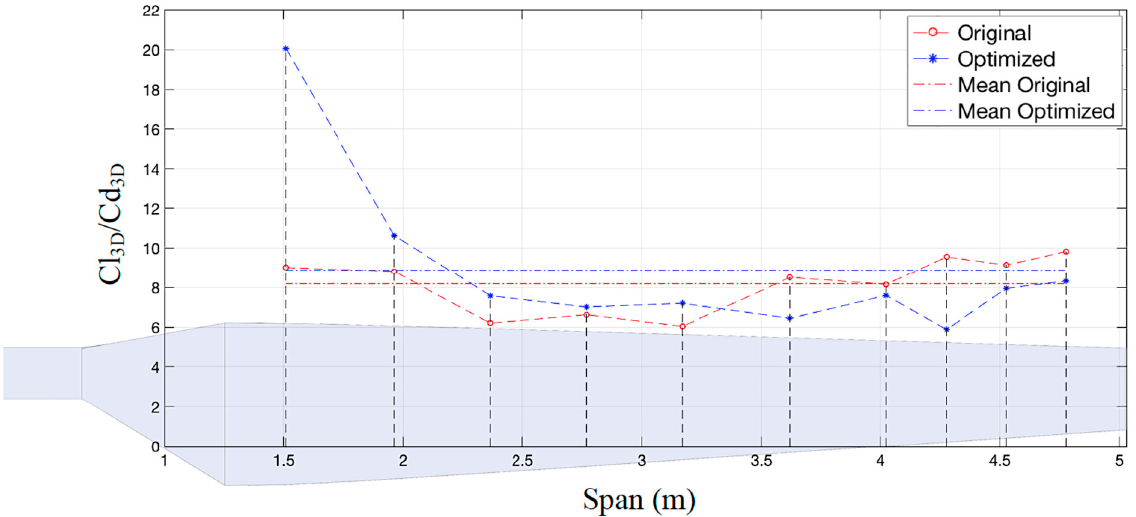
Figure 17. Cl 3D /Cd 3D ratio distributions for the original and optimized blades at 10 m/s.